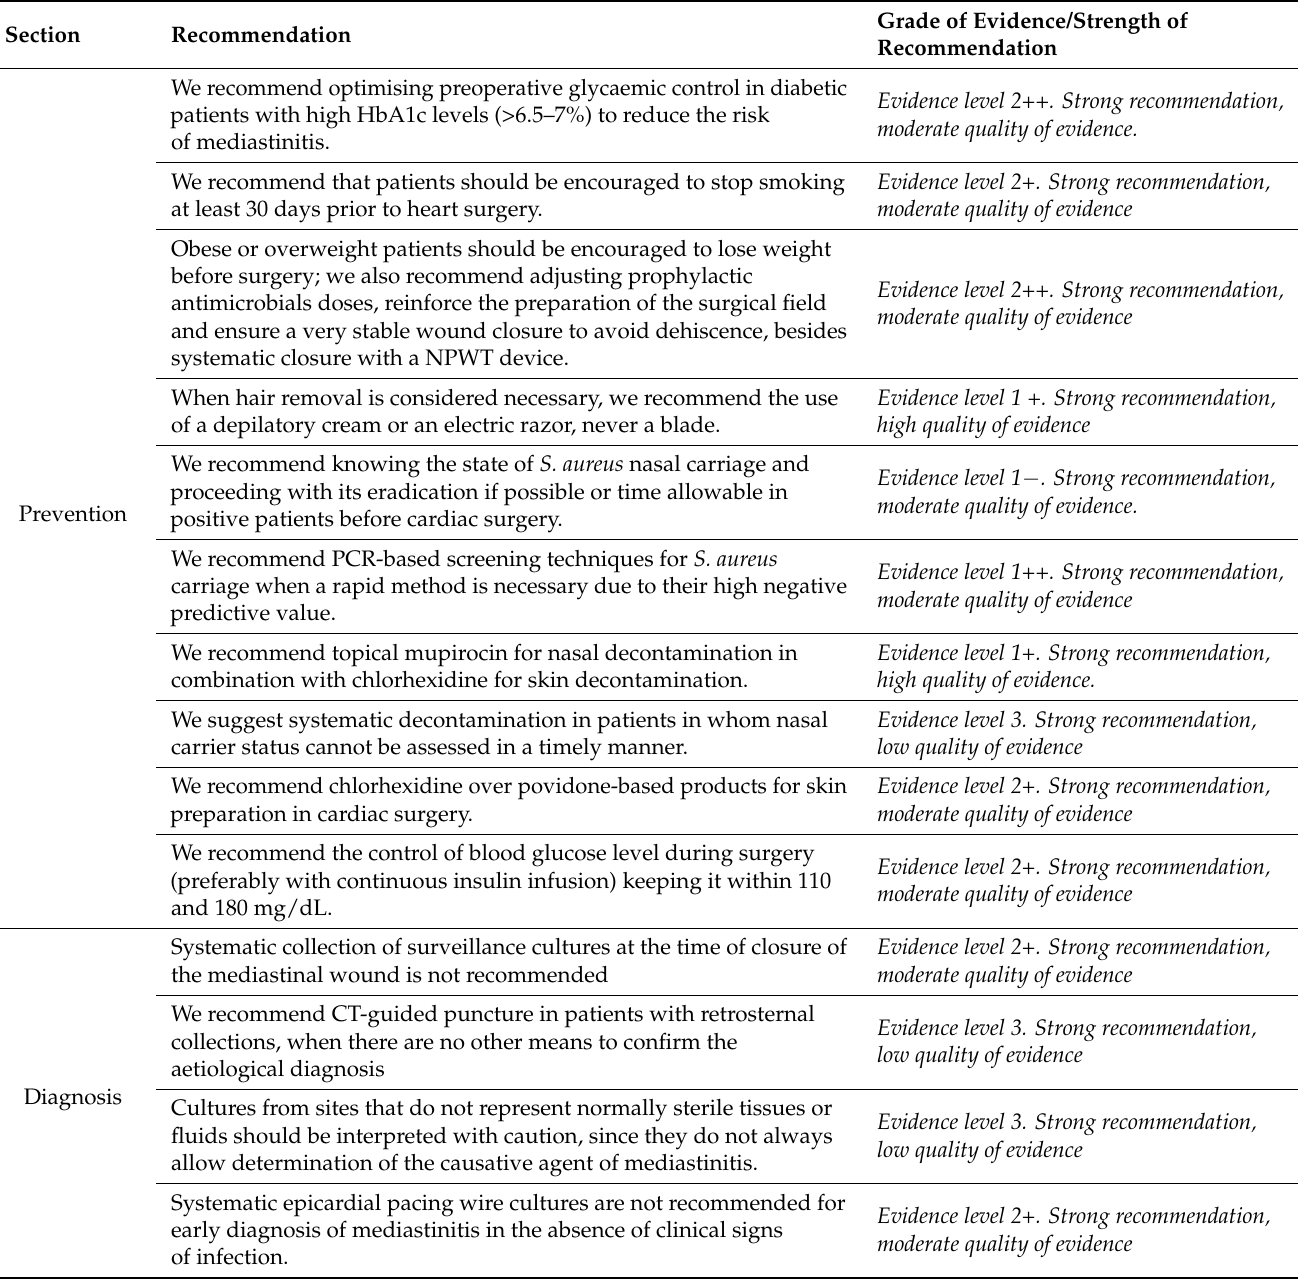
Summary table of recommendations and level of